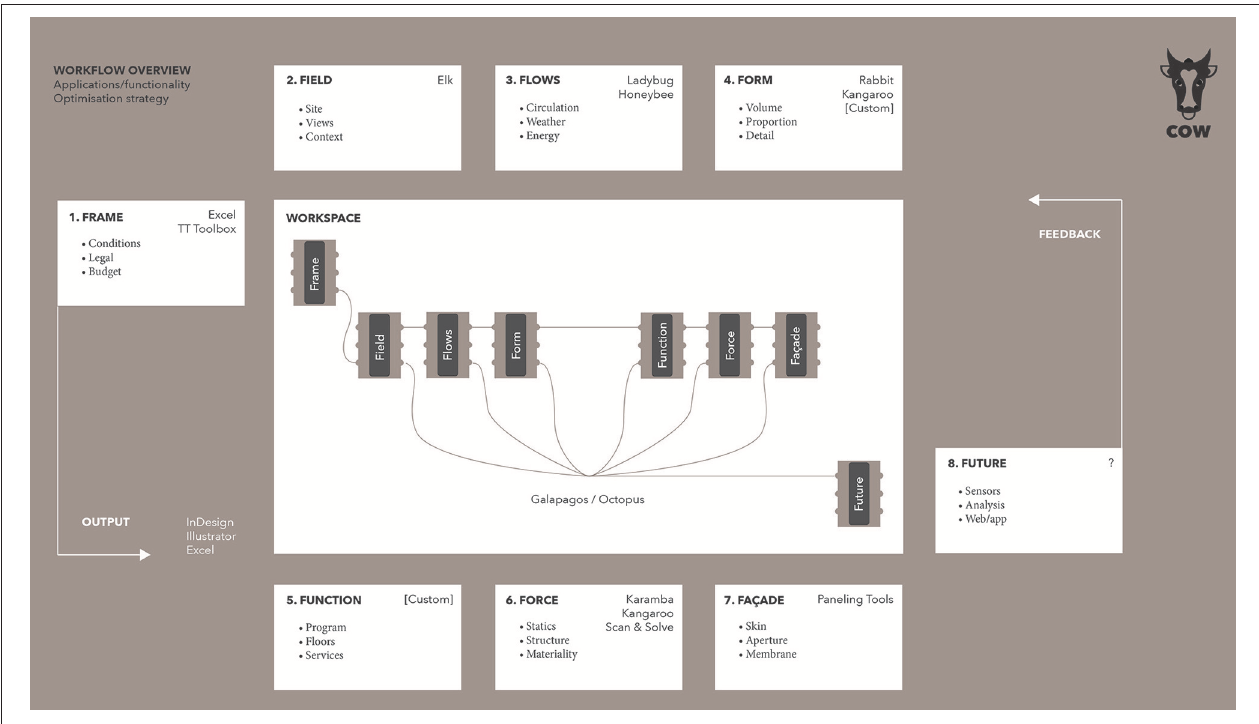
FIGURE 1 | The COW (Contextual Optimisation Workflow)